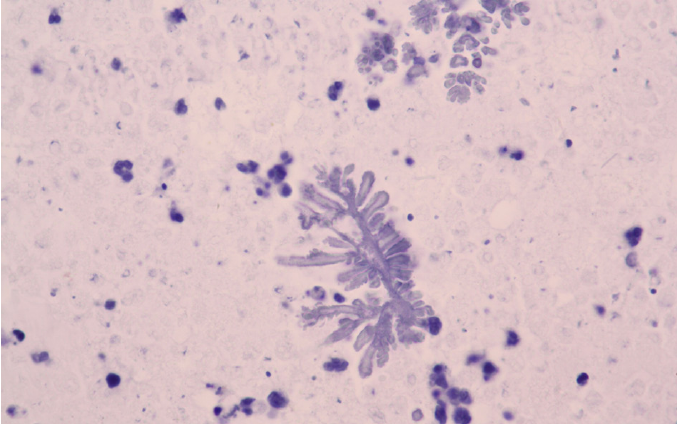
Fig. 2. A hyphal-like PAMRAG in mucoid substance (HE, ×400).